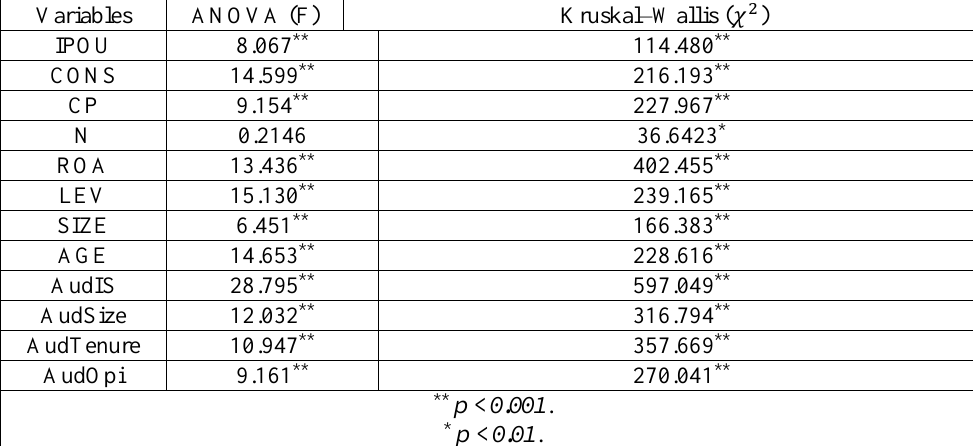
Table 5. ANOVA and Kruskal–Wallis of variables across the Twenty-three industrial sectors.